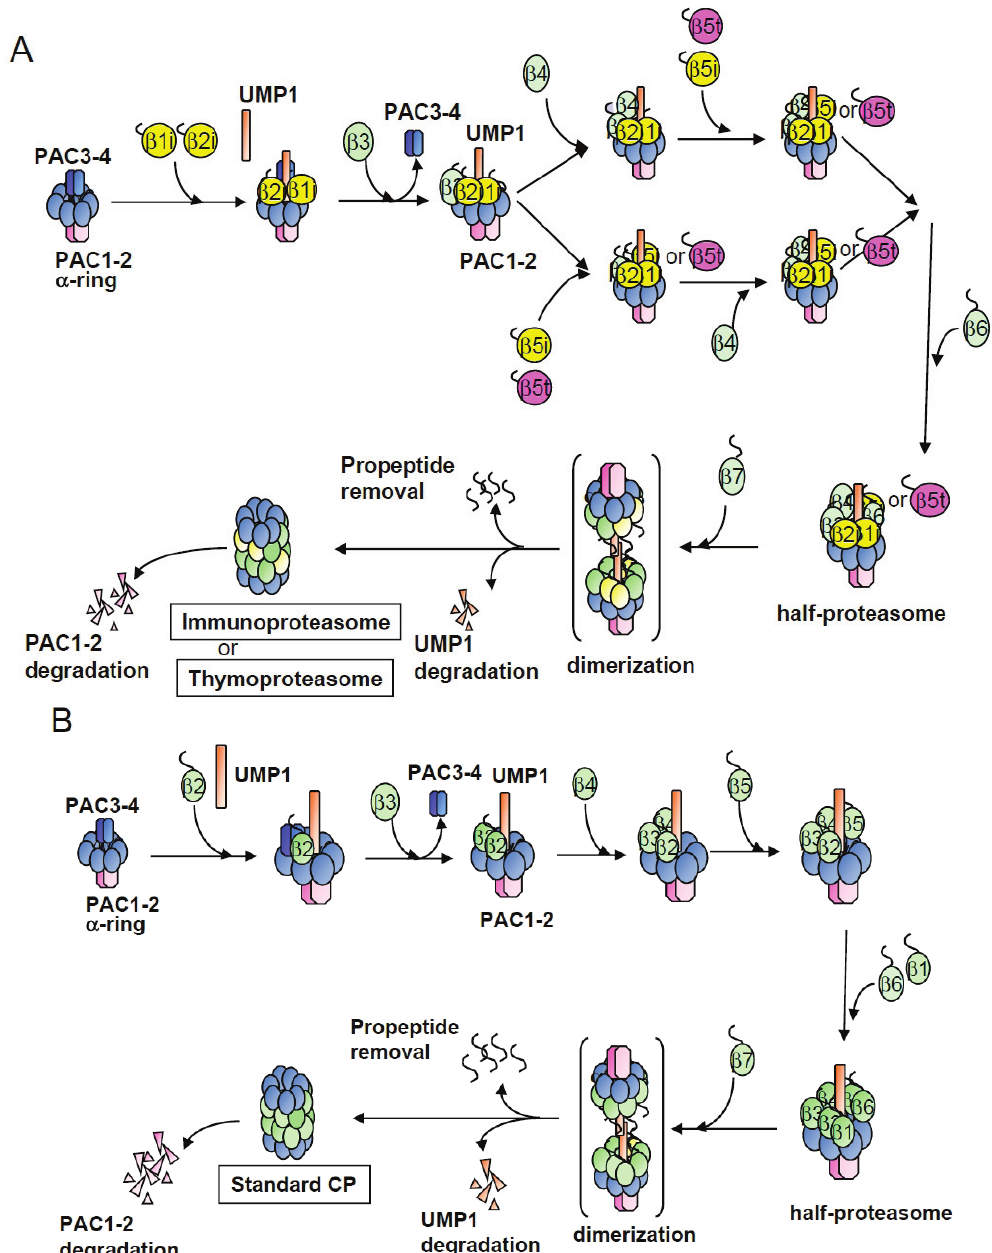
( B ) Assembly pathway of the standard CP for